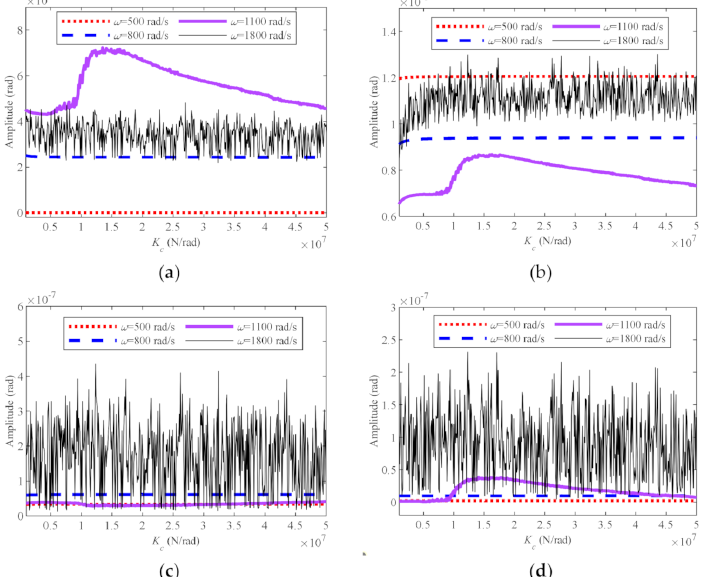
Figure 10. Curve of different frequency amplitudes varying with K c : ( a ) Half of the rotating frequency; ( b ) Rotating frequency; ( c ) Two times rotating; ( d ) Three times rotating